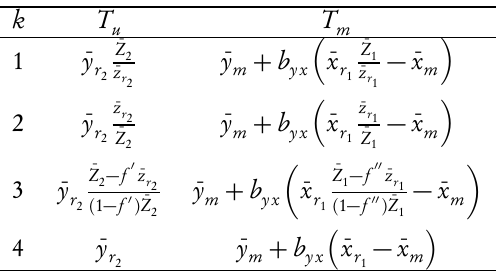
Special cases of T for specific values of